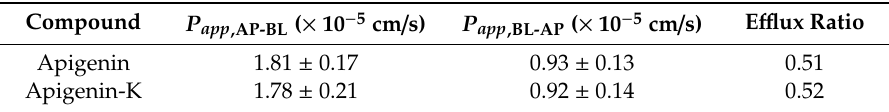
Table 2. Apparent permeability ( P app ) values for apigenin and apigenin-K from